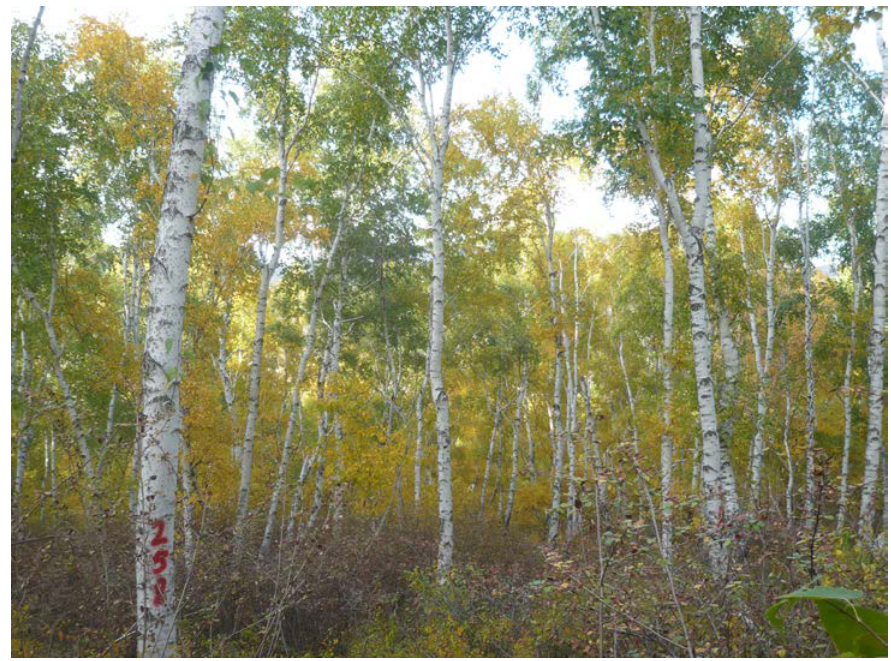
Figure A2. Birch stand BII during the data collection in 2012.